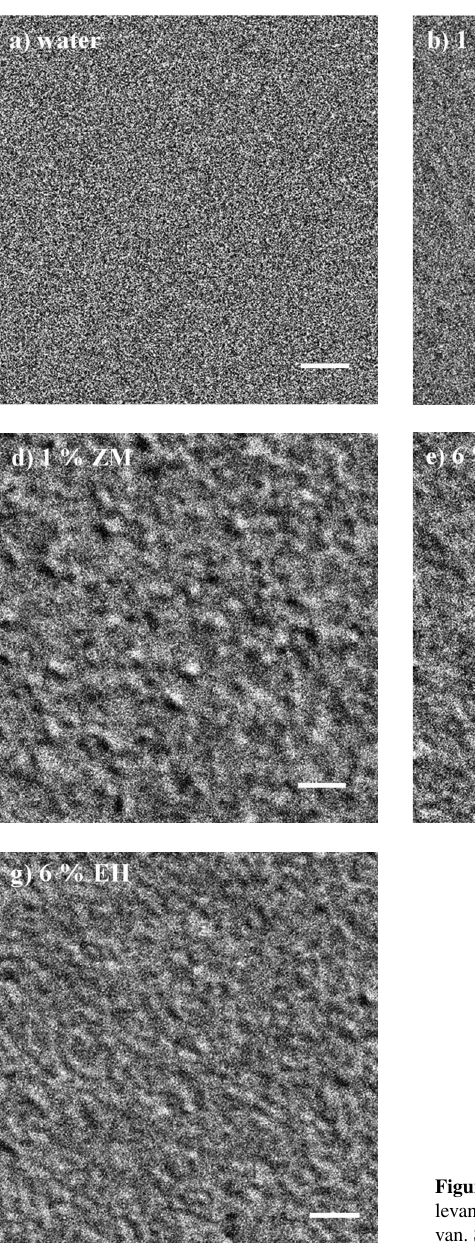
Figure 5: DIC microscopy image of a) solvent – water, b) 1% (w/v) BS levan, c) 6% (w/v) BS levan, d) 1% (w/v) ZM levan, e) 6% (w/v) ZM levan, f) 1% (w/v) EH levan, g) 6% (w/v) EH le- van. Scale bar represents 2